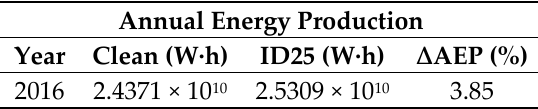
Table 1. Assessment of the